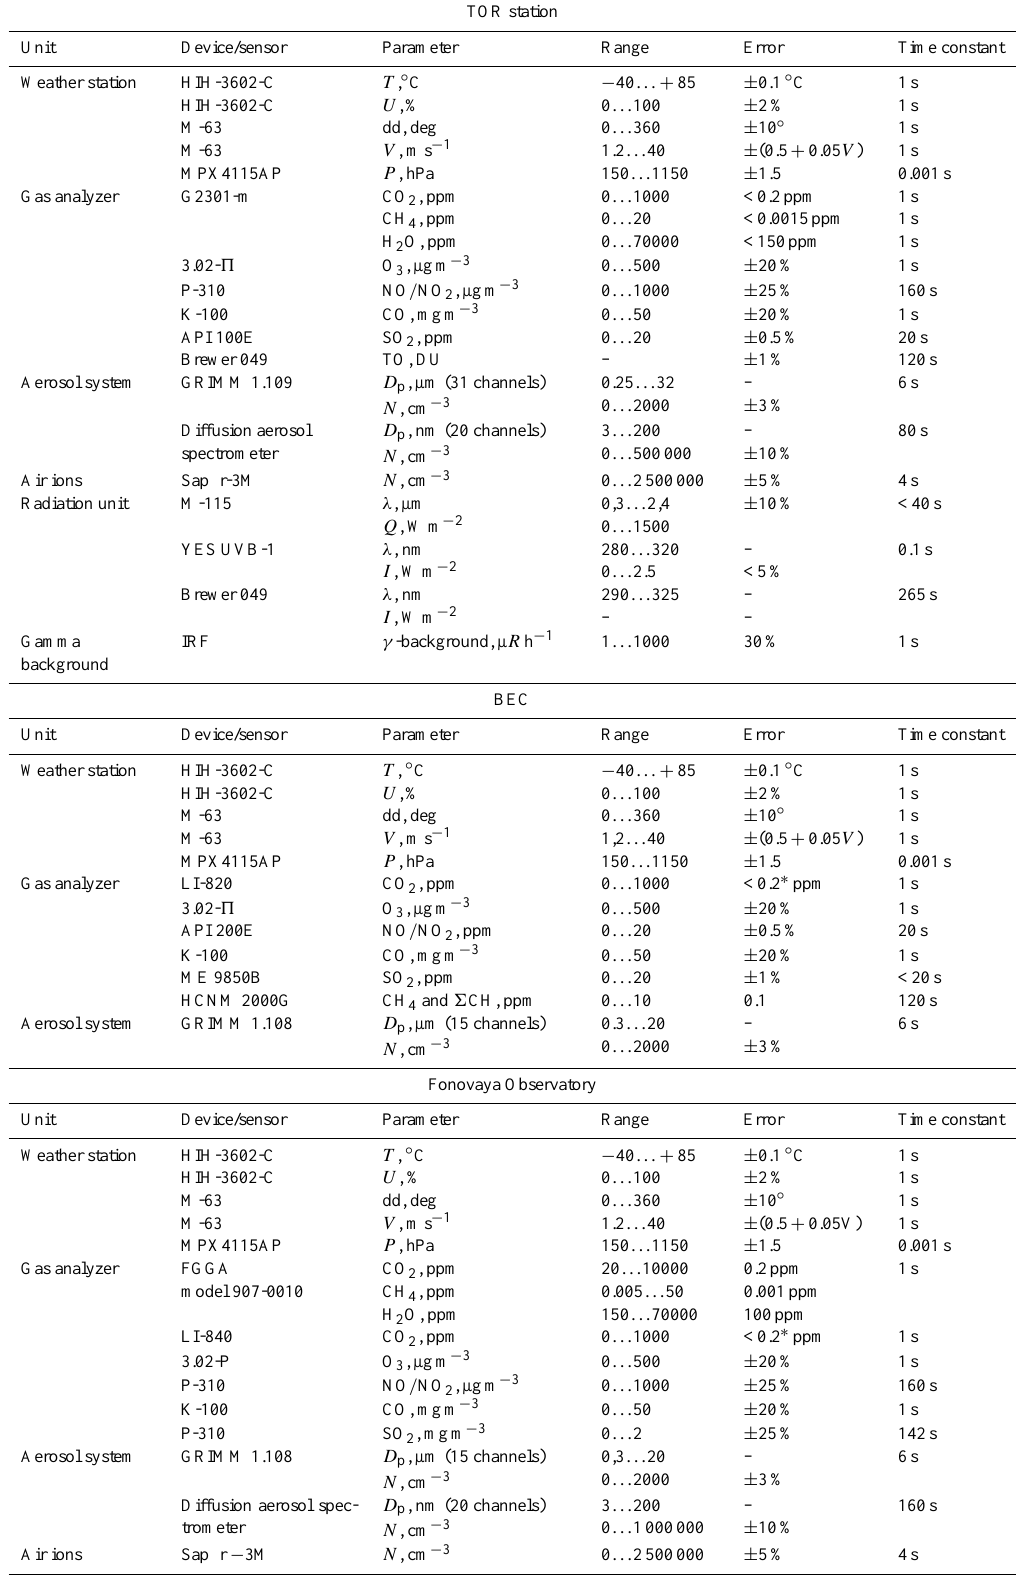
Table 2. Measurement facilities and their